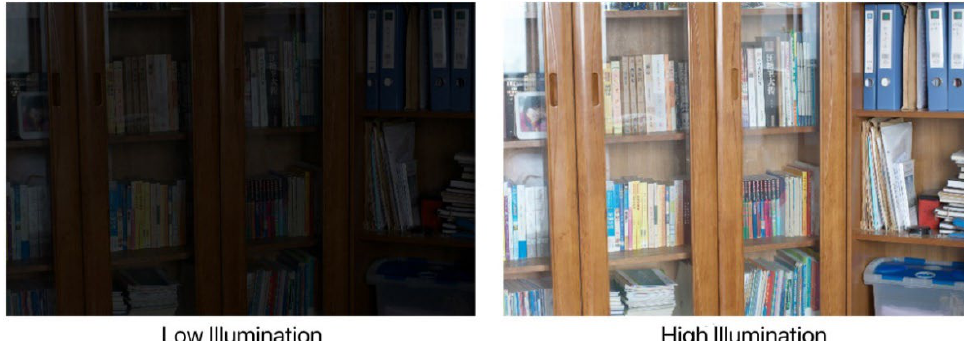
Figure 8. Different lighting images in the LOL